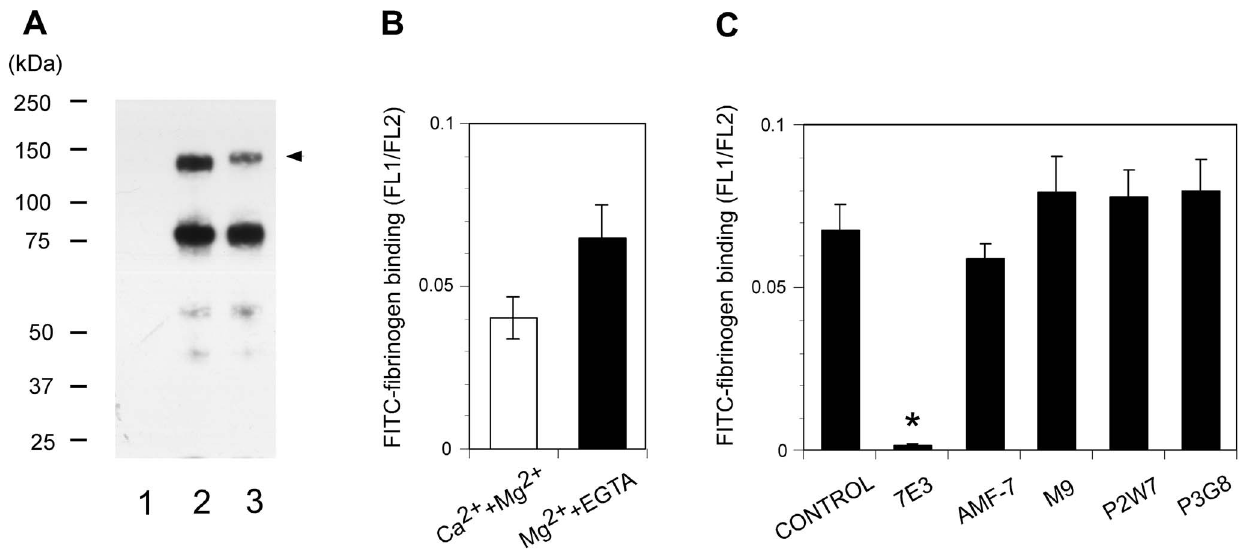
Figure 6. Effect of integrin extension on the function of the anti- a V b 3 mAbs. A. SDS-PAGE analysis of a V b 3 expressed on CHO cells. Cell lysates from biotin-labeled cells expressing a V b 3 were immunoprecipitated with anti- a V mAb P2W7. The precipitates were subjected to a 7.5% non- reducing gel and visualized using chemiluminescence. The positions of the molecular weight markers are shown on the left side of panel. Lane 1, parent CHO; lane 2, wild-type a V b 3; lane 3, Q589NAT. Note that the a V carrying the Q589NAT mutation (arrowhead) migrated more slowly than the wild type. B. FITC-fibrinogen binding to cells expressing a V b 3 carrying the Q589NAT mutation was examined as described in Fig. 4A. Binding in the presence of 1 mM Ca 2 + and 1 mM Mg 2 + (open column) or in the presence of 2 mM Mg 2 + and 5 m M EGTA (solid column) is shown. C. The effect of the anti- a V b 3 mAbs on fibrinogen binding to cells expressing a V b 3 carrying the Q589NAT mutation was examined, as described in Fig. 5B. Among the mAbs, only 7E3 significantly inhibited binding.